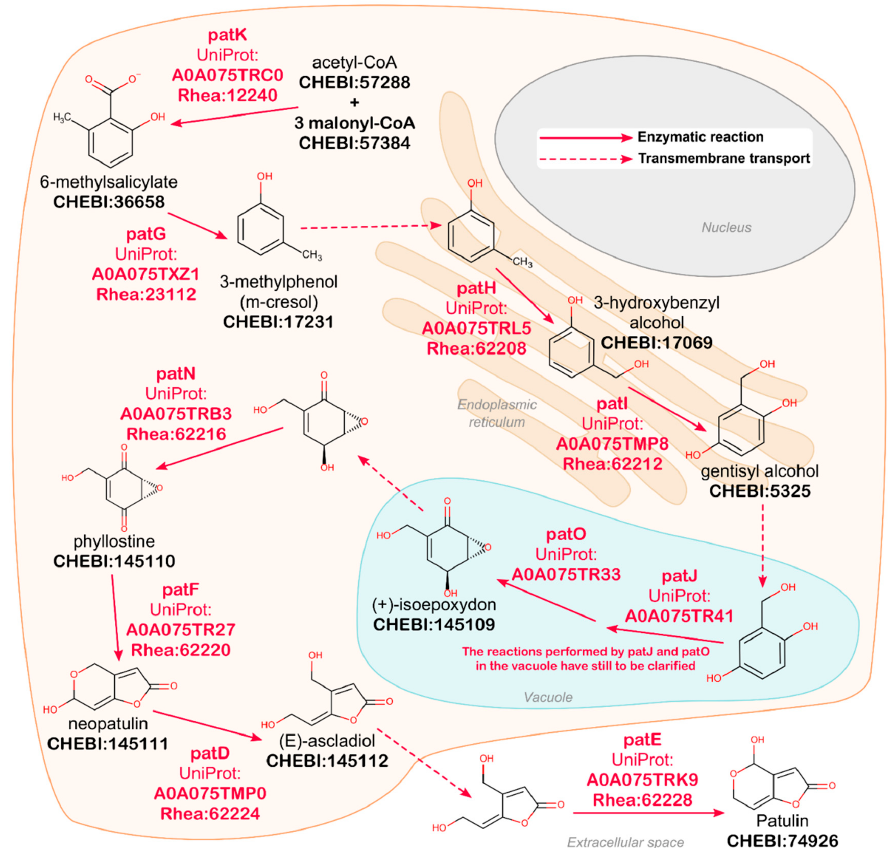
Figure 3. Curation of the patulin biosynthetic pathway in Penicillium expansum . The figure shows a schematic representation of the patulin biosynthesis pathway [28], which was fully curated in UniProtKB/Swiss-Prot. This pathway map was reconstructed using the 2D structures from ChEBI, the reactions provided by Rhea and their corresponding enzymes as annotated in UniProtKB (identifiers for each are indicated). UniProtKB/Swiss-Prot also provides additional data such as the subcellar location of each protein when known. The solid arrows indicate enzymatic reactions; the dashed arrows indicate transport reactions. The subcellular location of the enzymes illustrates the importance of compartmentalization for natural product biosynthesis [28]. All UniProtKB entry proteins involved in the patulin biosynthesis pathway can be retrieved using the following URL: www.uniprot.org/uniprot/?query=patulin&fil=organism%3A%22Penicillium+expan-